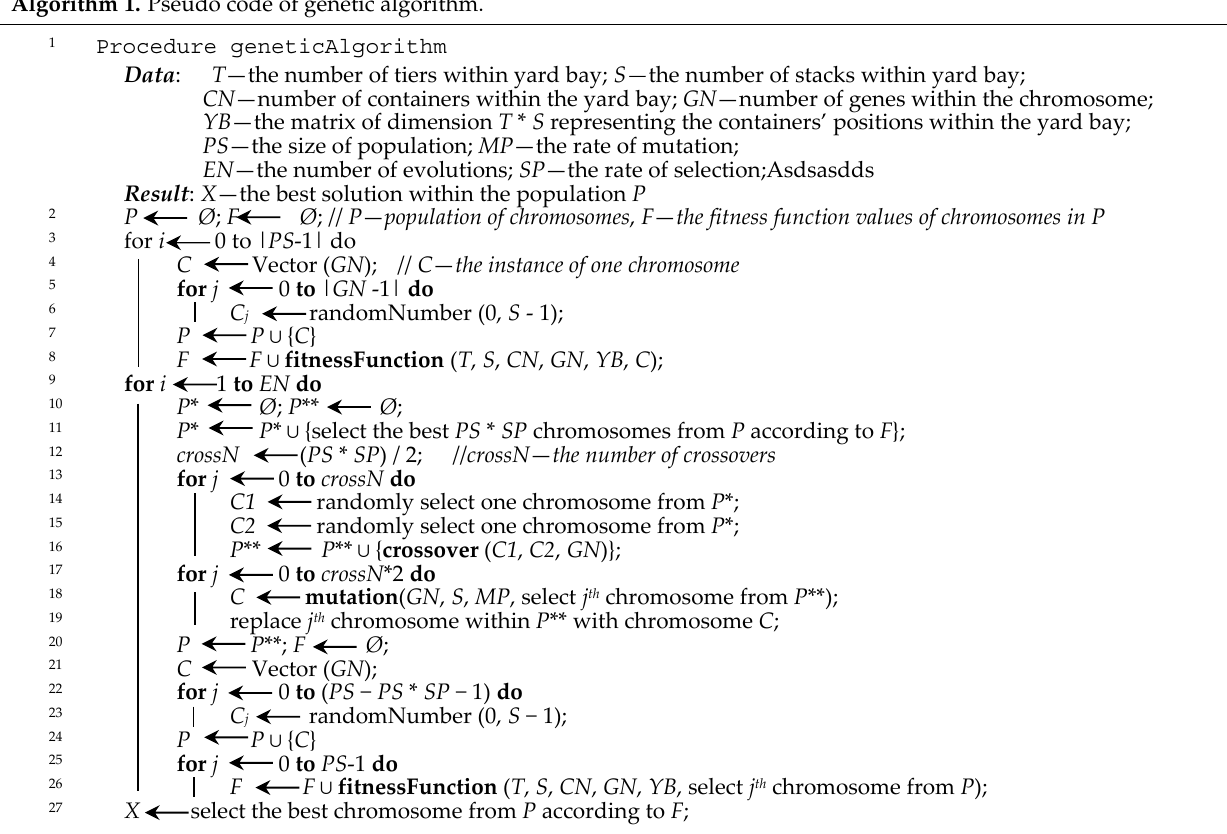
Algorithm 1. Pseudo code of genetic algorithm. Procedure geneticAlgorithm